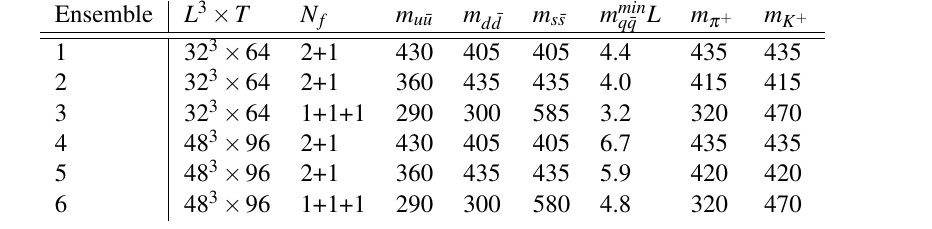
Table 1: Ensembles used in this work. All masses are in